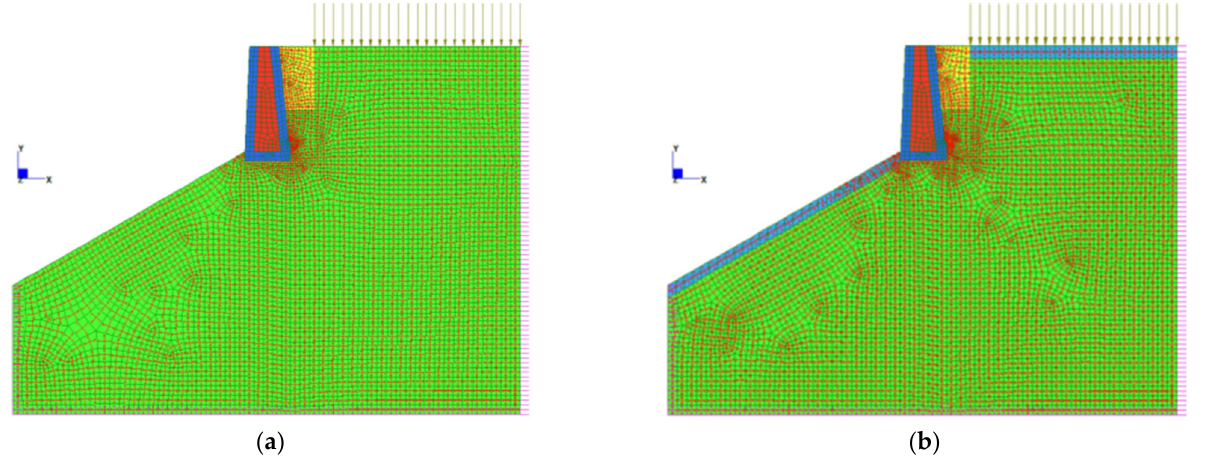
Figure 6. FEM model of sections 92–93. On the left, the standard model ( a ); and on the right, the modified model ( b ) that considered imbibition.